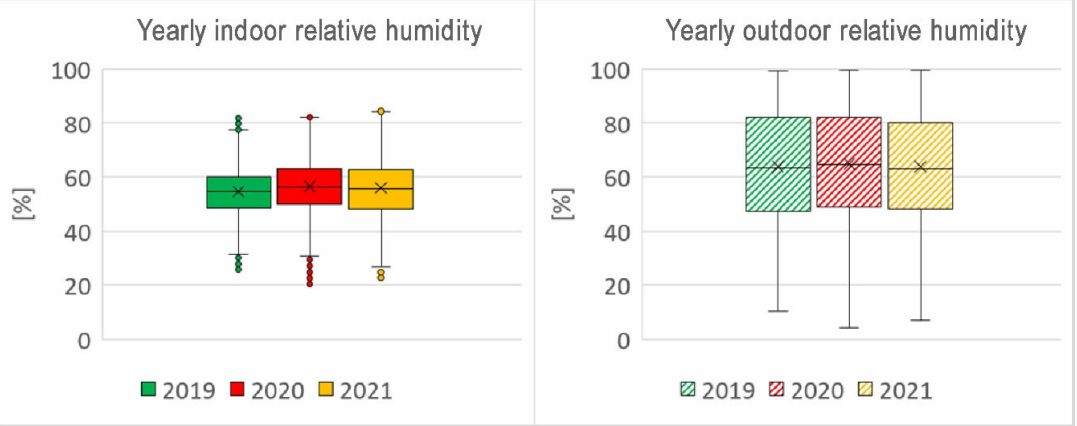
Figure 7. Comparison between the internal and external relative humidity for 2019, 2020 and